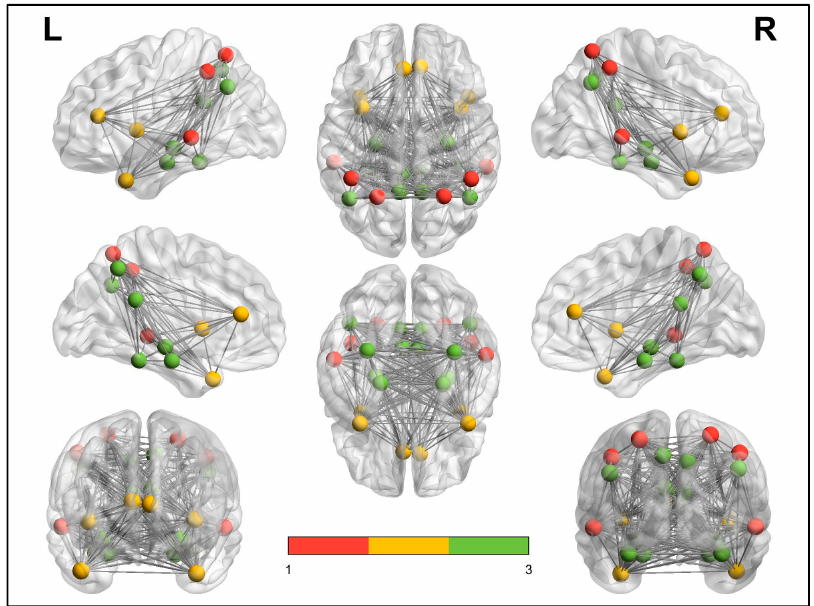
Figure 2. Exact localization of each ROI described in the Table 1. Red: DMN. Yellow: DMN anterior. Green: DMN ventral. The edges are simulated to facilitate the representation.